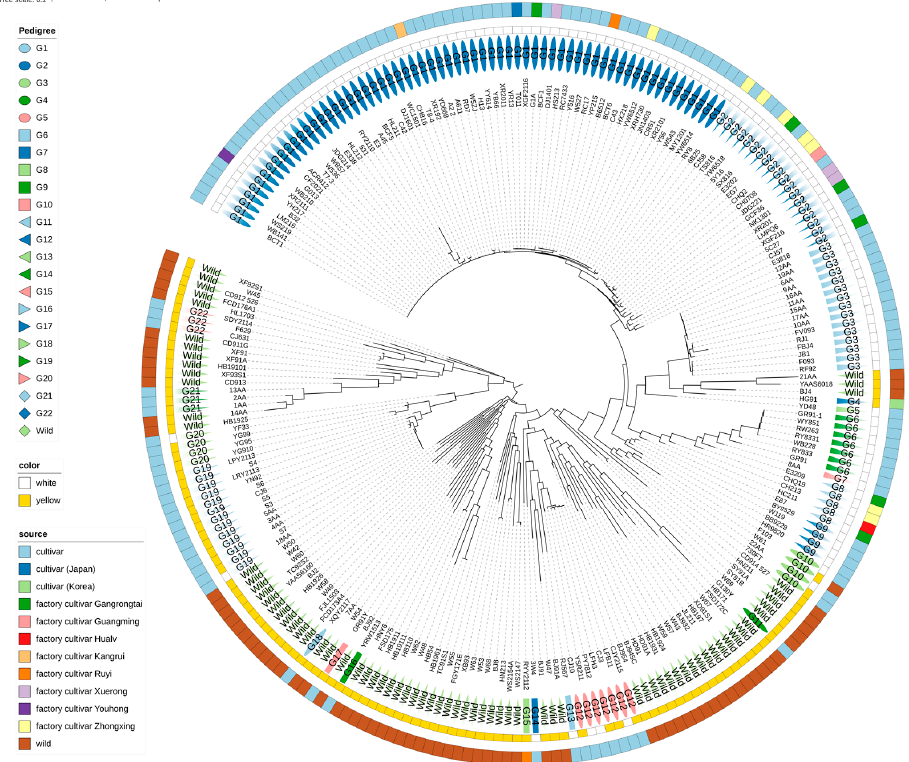
Figure 2. Phylogenetic tree of F. filiformis based on 69 core MNP sequences from 232 F. filiformis strains. For each strain, the innermost color ring represents the pedigree of the strain, the second ring indicates pileus color, and the outer ring indicates the original source of the strain.